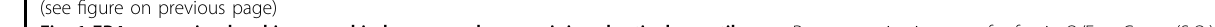
Fig. 1 EP4 expression level increased in human and mouse injured articular cartilage. a Representative images of safranin O/Fast Green (S.O.) and immuno fl uorescence staining for EP4 in the uninjured or injured human adult articular cartilage from human OA patients (left). The EP4 expression was quanti fi ed (right). Nucleus were shown by DAPI staining. Scale bar, S.O. staining, 200 μ m, immuno fl uorescence staining; 50 μ m. Error bars are means ± s.d., n = 3, * P < 0.05 by student t -test. b Scatter plot showing the linear correlation between MMP3 expression and EP4 in articular cartilage of human OA patients. Two to three articular cartilage explants from each patient were collected. Samples from ten patients were subject to qRT-PCR. Pearson ’ s correlation analysis was performed. c Representative images of S.O. staining on sham operated or MF at 4 weeks after surgery. Scale bar, 200 μ m. EP4 expression level increased in the mouse articular cartilage defect region 4 weeks after MF surgery, co-stained with Acan. Sham- operated mice were used as controls. Scale bar, 50 μ m. The EP4 expression was quanti fi ed (right). Error bars are means ± s.d., n = 3. * P < 0.05 by student t -test. White dotted lines indicated the surface of articular cartilage and dotted boxes indicated the defect region. d Sham or DMM surgery was carried out at 10-week-old mice. Representative images of S.O. staining of sham-operation or DMM group at 6 weeks after surgery. EP4 expression levels increased in the mouse articular cartilage defect region 6 weeks after the DMM surgery (left). Scale bar, 50 μ m. The EP4 expression was quanti fi ed, co-stained with Acan (right). Error bars are means ± s.d., n = 3. * P < 0.05 by student t -test. White dotted lines indicated the surface of articular cartilage. e , f qRT-PCR analysis for human EP4 in primary chondrocyte cells from human OA patients ’ uninjured articular cartilage treated with or without IL-1 β (1 ng/ml) ( e ) or TNF- α (10 ng/ml) ( f ) stimulation for 24 h. Error bars are means ± s.d., n = 3. * P < 0.05, ** P < 0.01 by student t -test. g , h qRT-PCR analysis for mouse EP4 in primary mouse articular chondrocyte cells with IL-1 β (1 ng/ml) ( g ) or TNF- α (10 ng/ml) ( h ) stimulation for 24 h. Error bars are means ± s.d., n = 3. * P < 0.05, *** P < 0.001 by student t